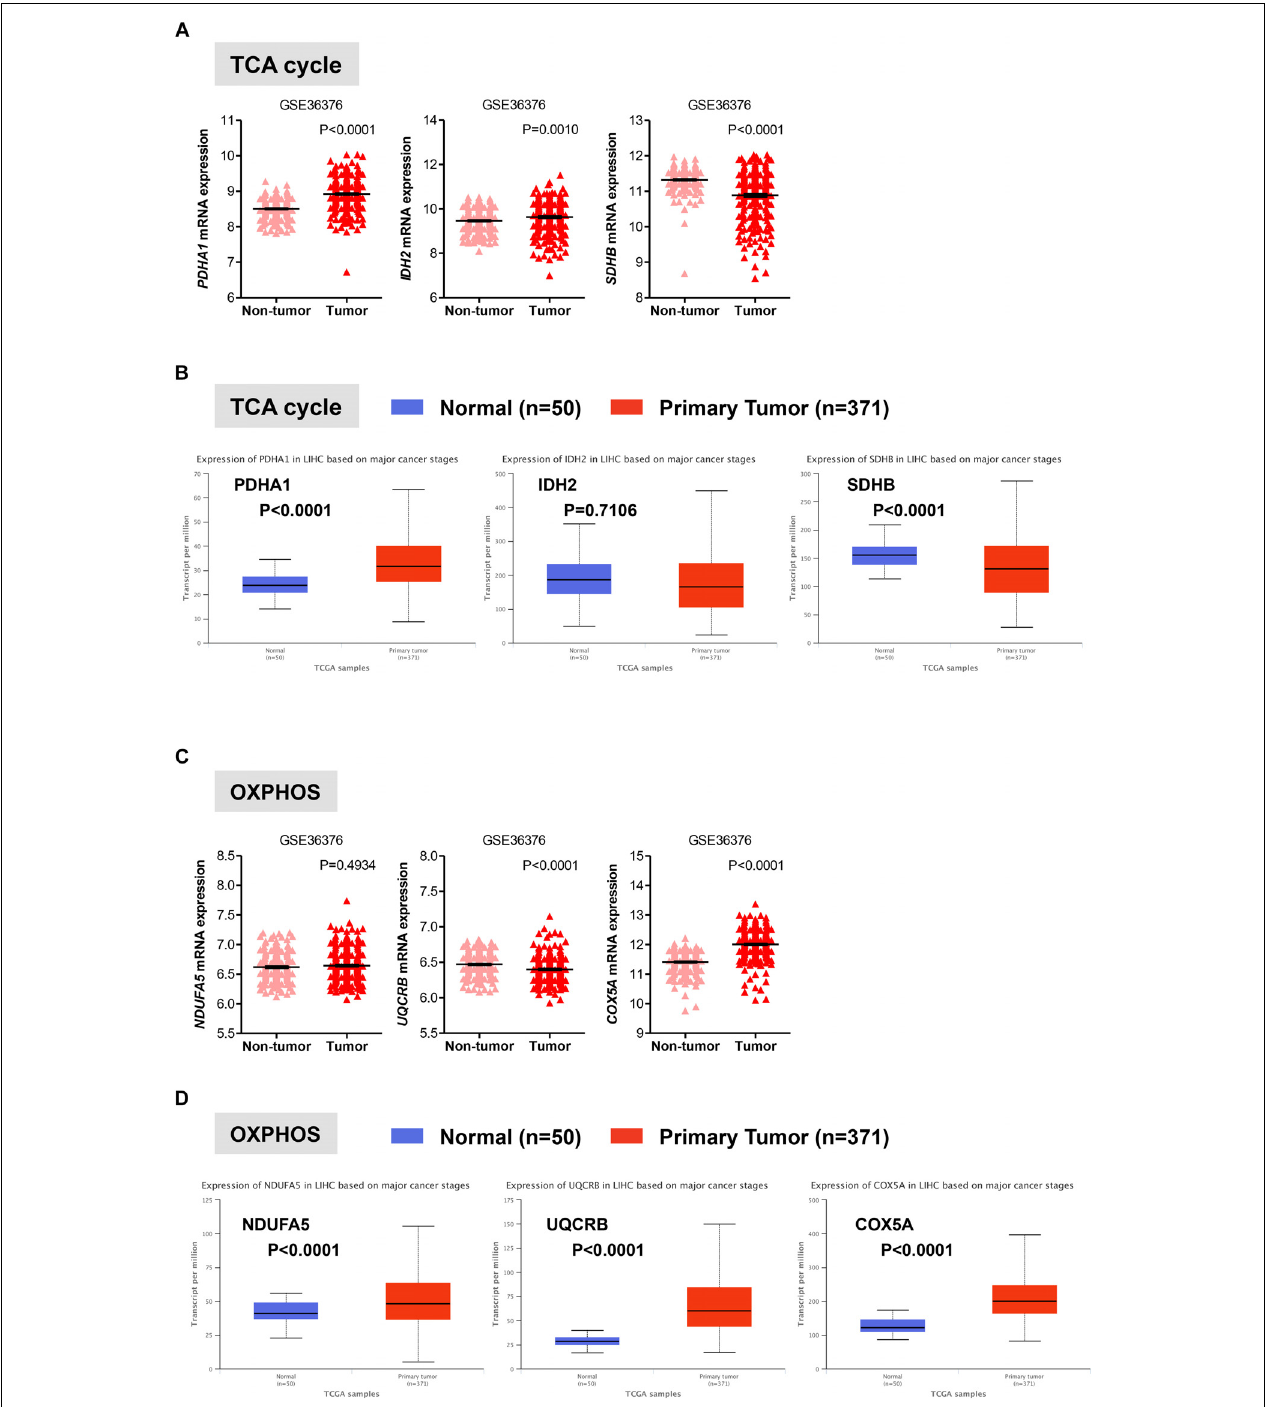
FIGURE 3 | Gene expression analysis of the oxidative mitochondrial metabolism in HCC. (A,C) Scatterplots showing the transcript levels of representative TCA (A) and OXPHOS (C) enzymes in the clinical data set GSE36376 consisting of HCC ( n = 240) and adjacent non-tumor ( n = 193) liver tissue (Lim et al., 2013). The horizontal lines indicate mean ± SEM P -values were calculated by nonparametric Mann–Whitney tests. (B,D) Boxplots showing differential gene expression of TCA (B) and OXPHOS (D) among normal liver tissues ( n = 50) vs. primary tumor tissues ( n = 371) (TGA-LIHC samples) analyzed using the UALCAN bioinformatic tool of genomic database (Ally et al., 2017; Chandrashekar et al., 2017). Values are expressed as transcript per million. For each box plot, the whiskers represent the 2.5–97.5th percentile range of values, the lower and up boundaries denote the 25th and the 75th percentile of each data set, respectively, and the horizontal line represents the median value for each group. P -values were calculated by t